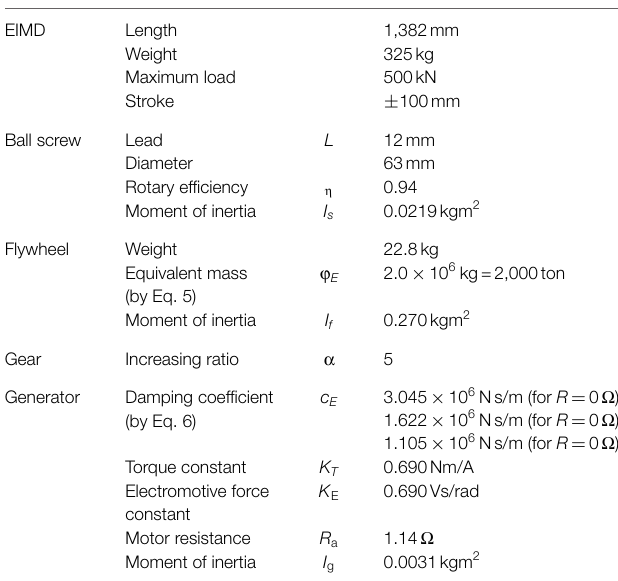
Makeup of T-EIMD The T-EIMD employs the EIMD ( Figure 2 ) for the IMD in Figure 4 . Since the EIMD produces the inertial force and the electromagnetic damping force, the T-EIMD does not require the supplemental damper. A spring element is connected in series with the EIMD, and adjusts the natural period of the T-EIMD. In the mechanical model of the T-EIMD ( Figure 4 ), k d denotes the stiffness of the spring element for tuning the period, and δ T and δ E denote the total amplitude of the T-EIMD and the stroke of the EIMD, respectively. δ T can be regarded to be the same